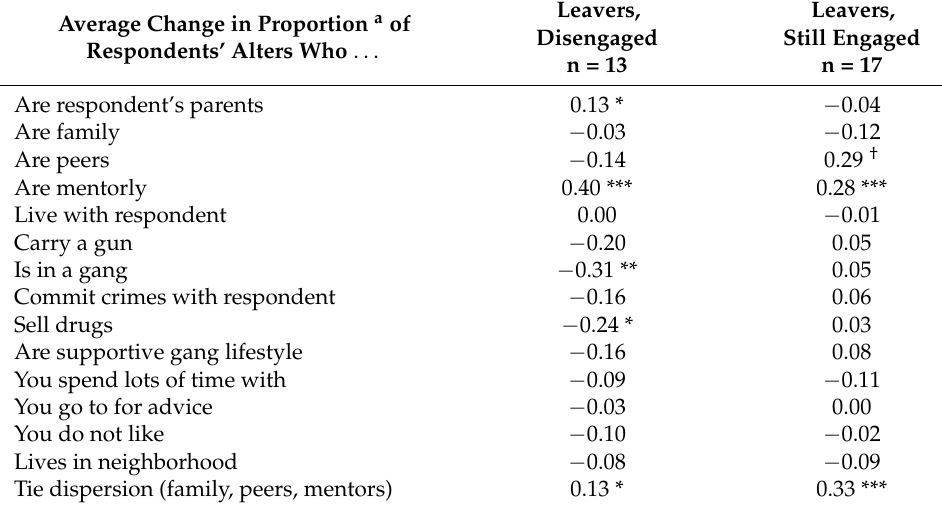
Table 8. Changes in Composition of Respondents’ Networks between